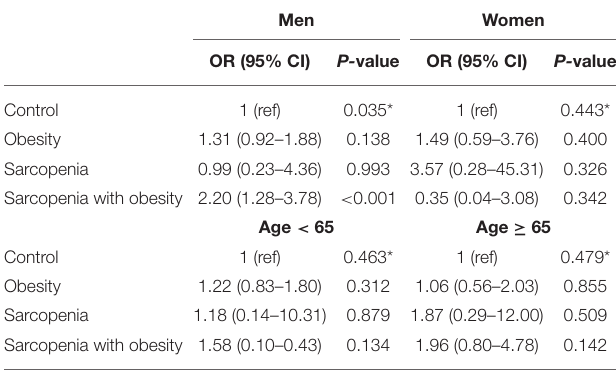
TABLE 4 | Subgroup analysis of the risk for coronary artery calcification according to sarcopenia with or without